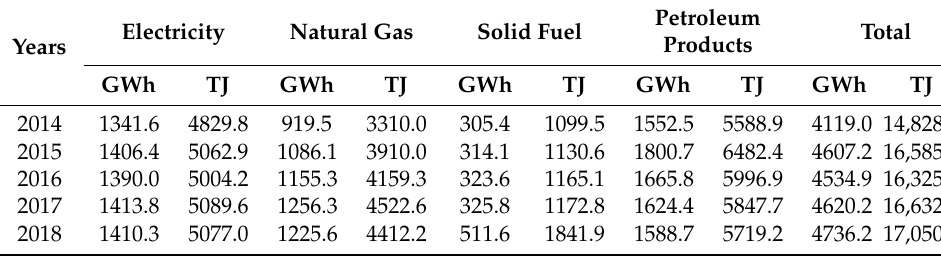
Petroleum Products